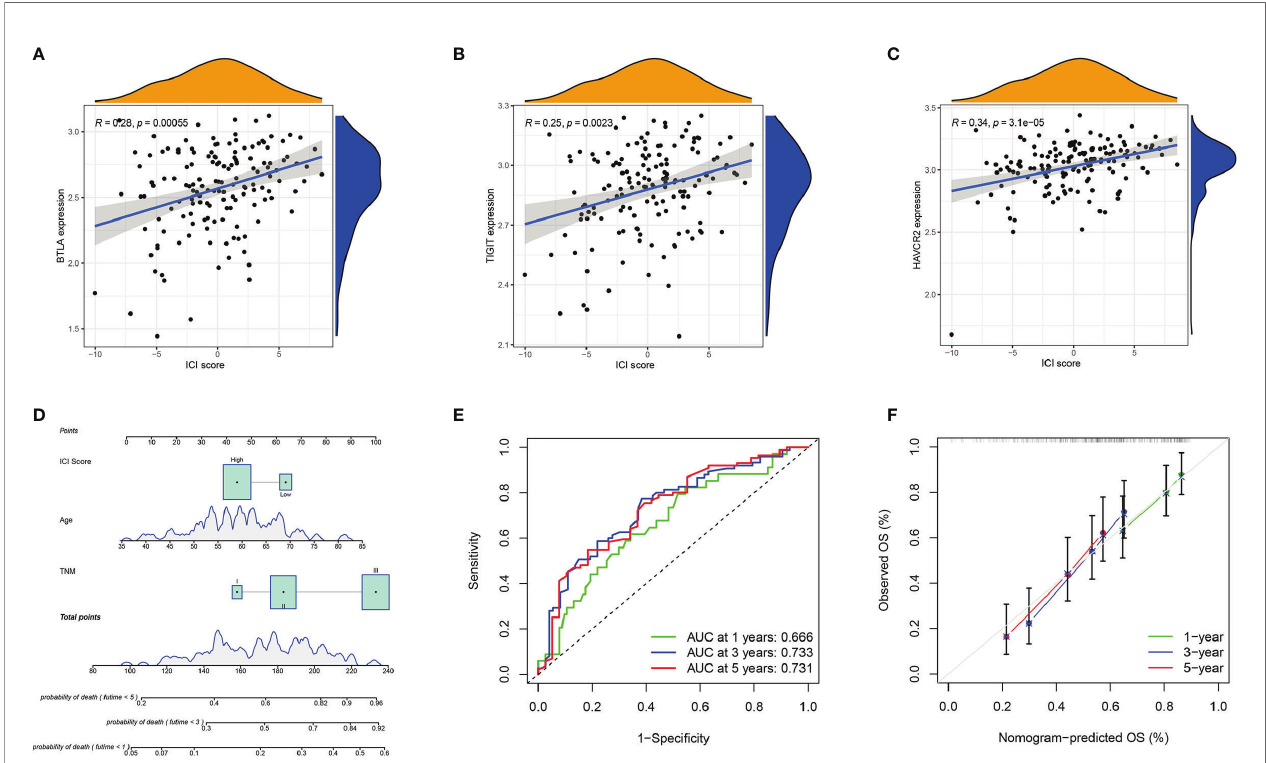
FIGURE 6 | Prognosis Signi fi cance of ICI Scores. (A – C) Correlation analysis between the ICI score with the three differentially expressed immune checkpoint signature genes ( BTLA , TIGIT , and HAVCR2 ). BTLA (A) , TIGIT (B) , and HAVCR2 (C) ; (D) The nomogram for predicting 1-, 3-, or 5- year probability of death; (E) The ROC curve of the nomogram for predicting the 1-, 3-, or 5- year probability of death. (F) The calibration curve of the nomogram for predicting the 1-, 3-, or 5- year probability of